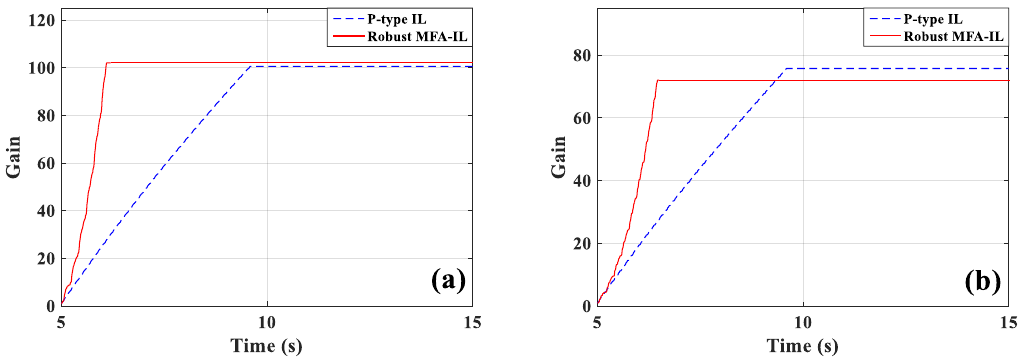
Figure 20. The learning processes of feedback gains: (a) Actuators a / b , (b) actuator c.